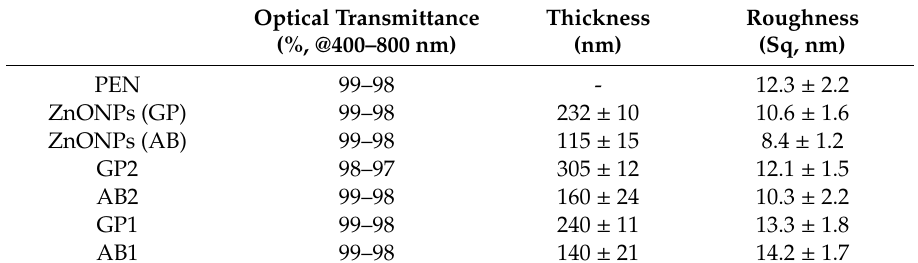
Figure 3. Fourier-transform infrared (FT-IR) spectra on CaF 2 substrates of the ZnONPs layer deposed by airbrushing (black trace), ZnO NPs / stearic acid AB1 (red trace) and AB2 (blue trace) coatings.